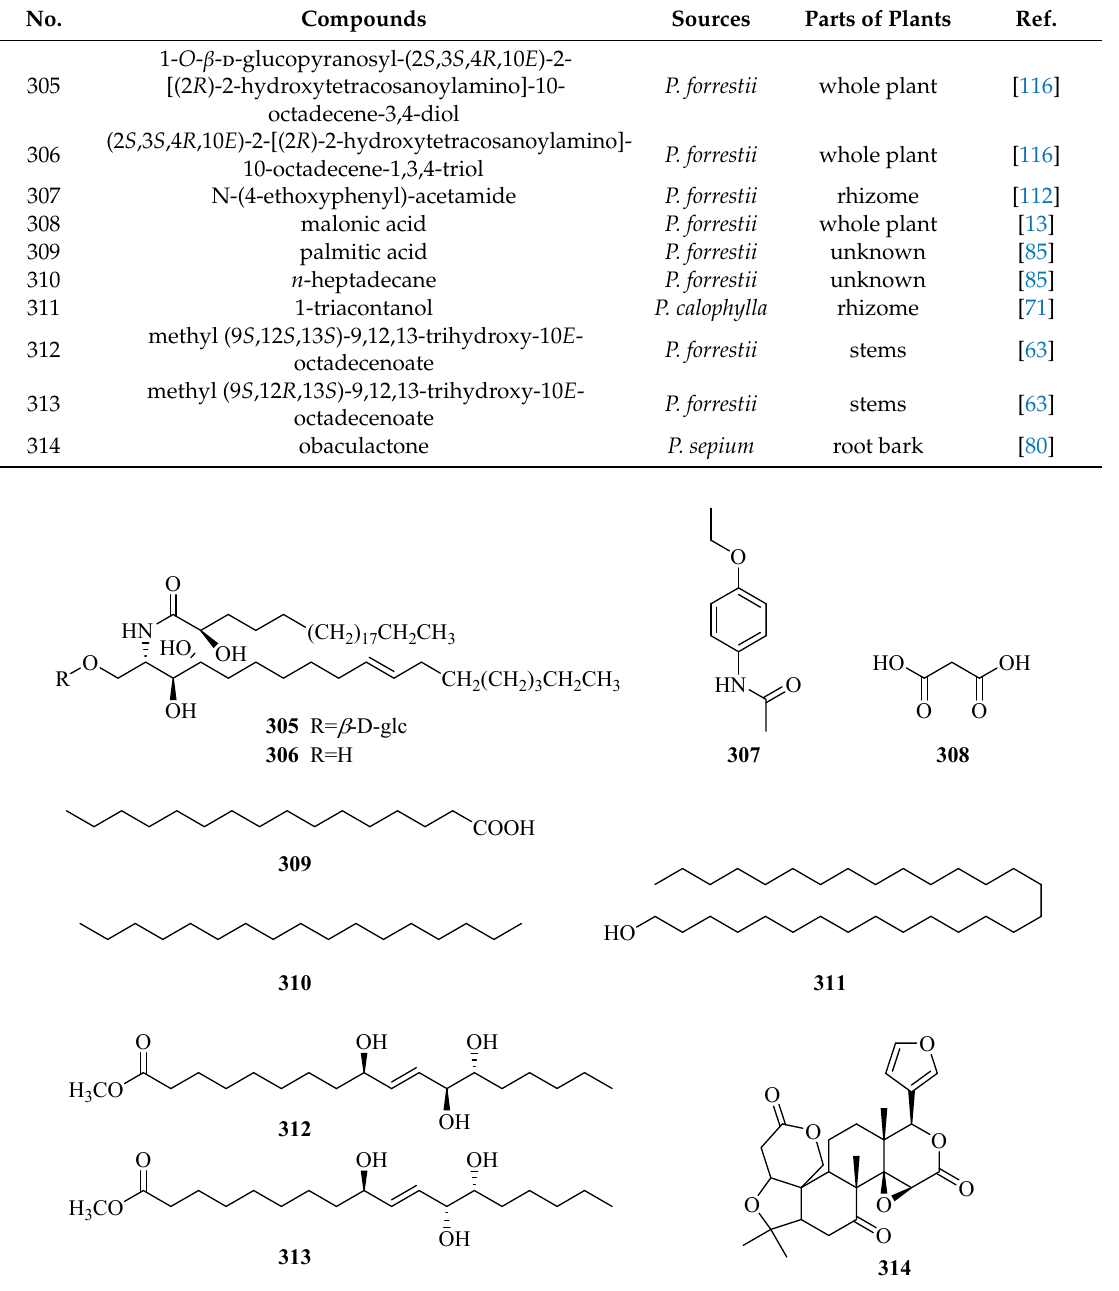
Figure 11. Other compounds from the genus Periploca .